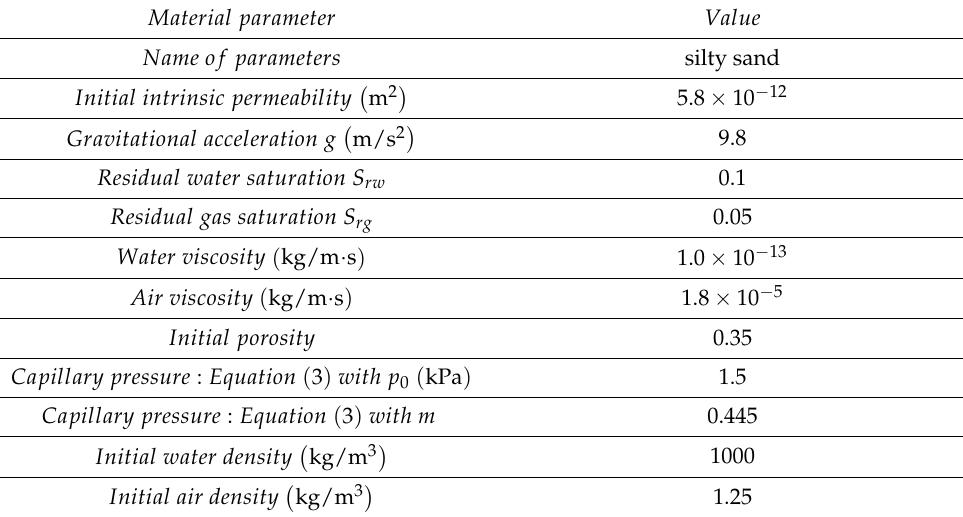
Table 1. Parameters for the numerical simulation. Material parameter